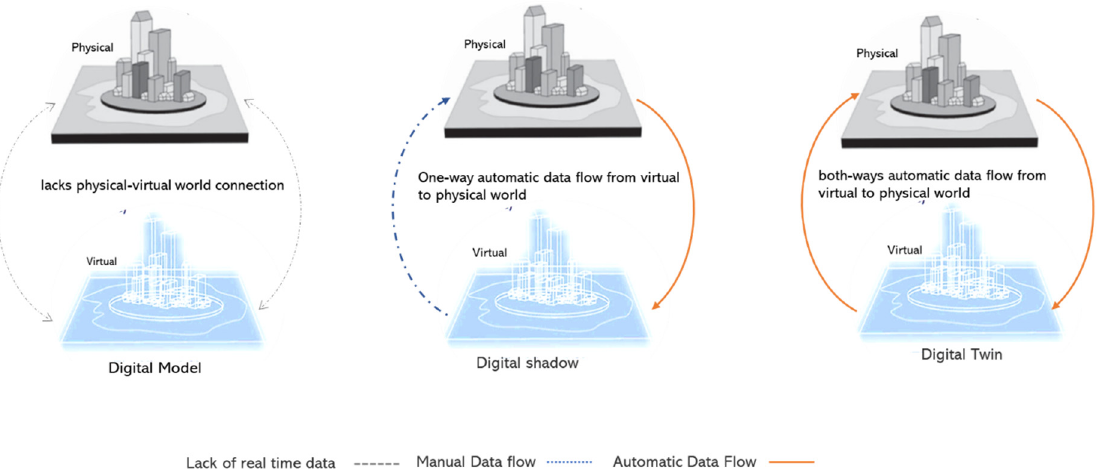
Figure 1. Illustration of the difference between digital model ( left ), Digital shadows ( centre ), and digital twin ( right ) with the aid of automatic and manual data flow between the virtual and real world.